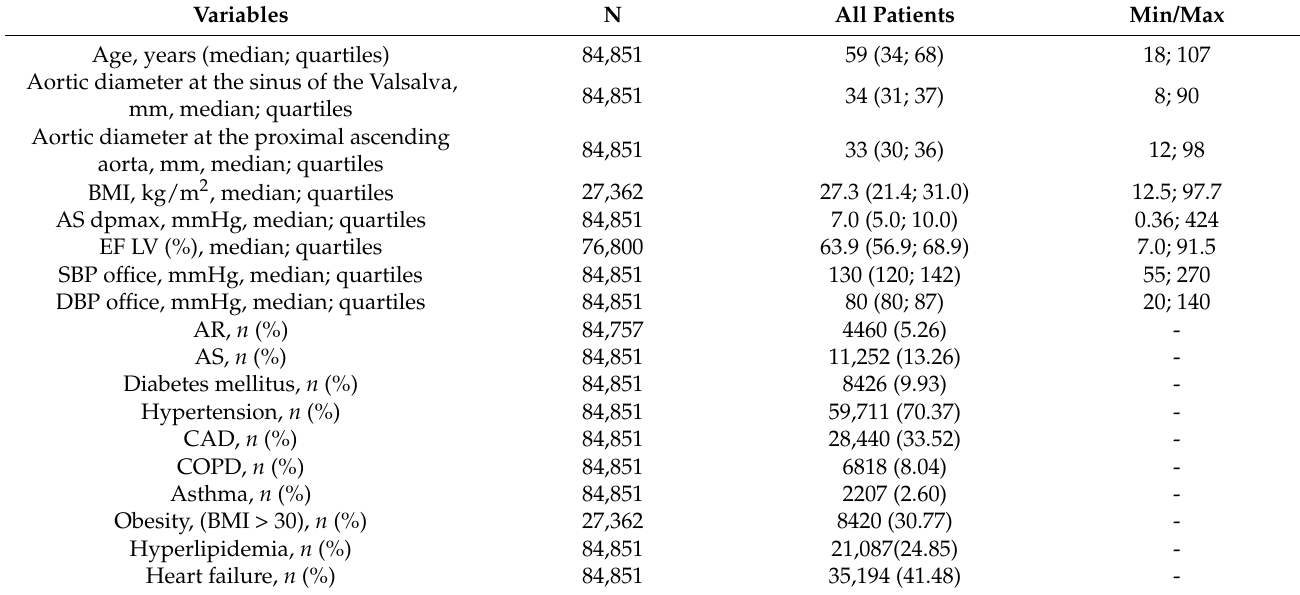
Table 1. Demographic and clinical characteristics of all